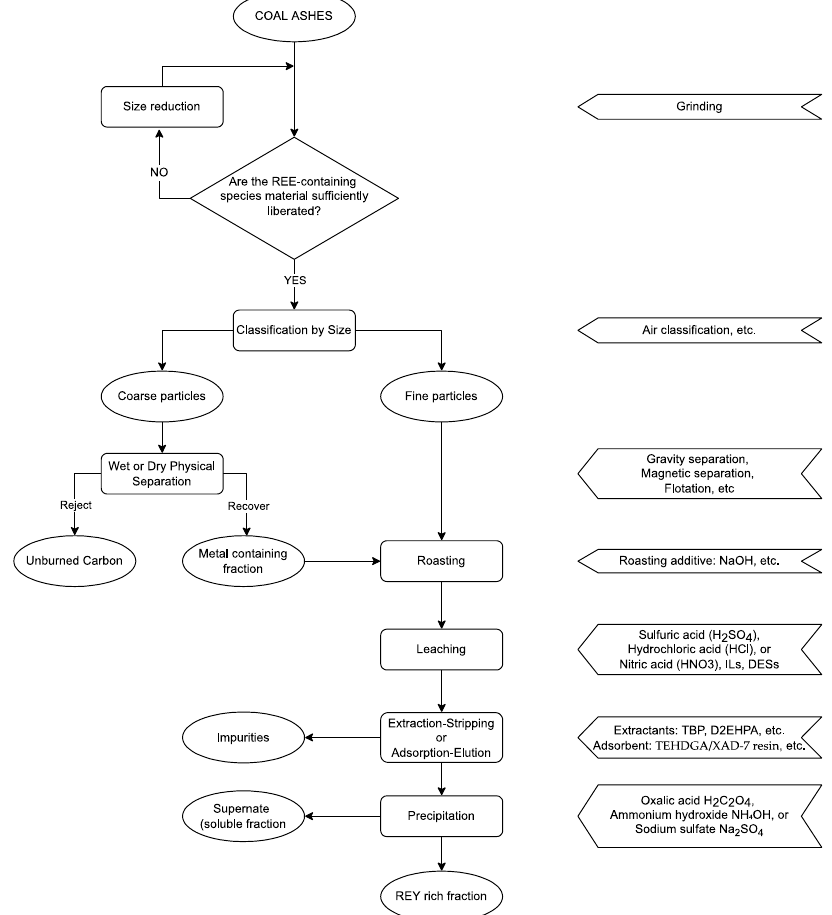
Figure 1. A conceptual flowsheet for recovering REY from coal ashes.